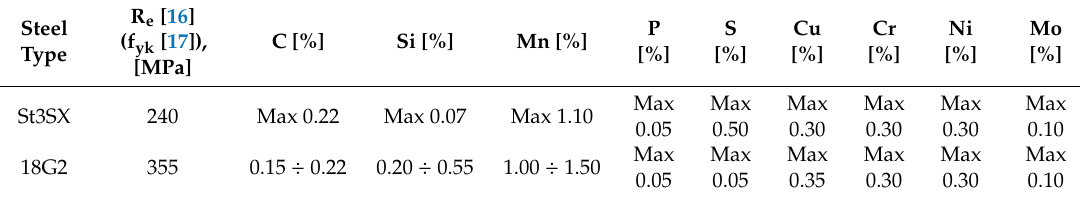
Table 2. Chemical characteristics and yield stress of reinforcing steel [16].